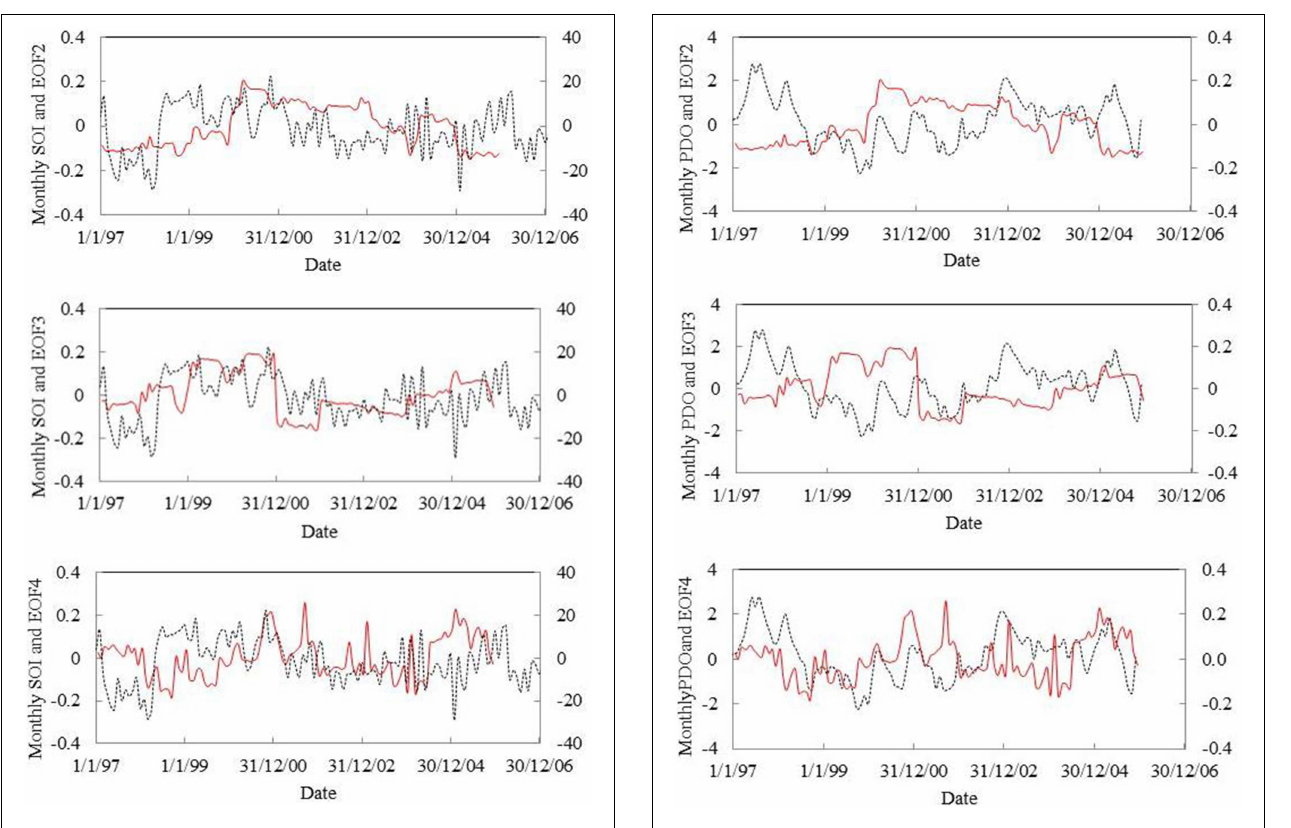
FIGURE 14 | Comparison of temporal EOFs with PDO. Primary axis corresponds to PDO. Secondary axis corresponds to temporal EOFs. Red line—temporal EOF, black dotted line—monthly